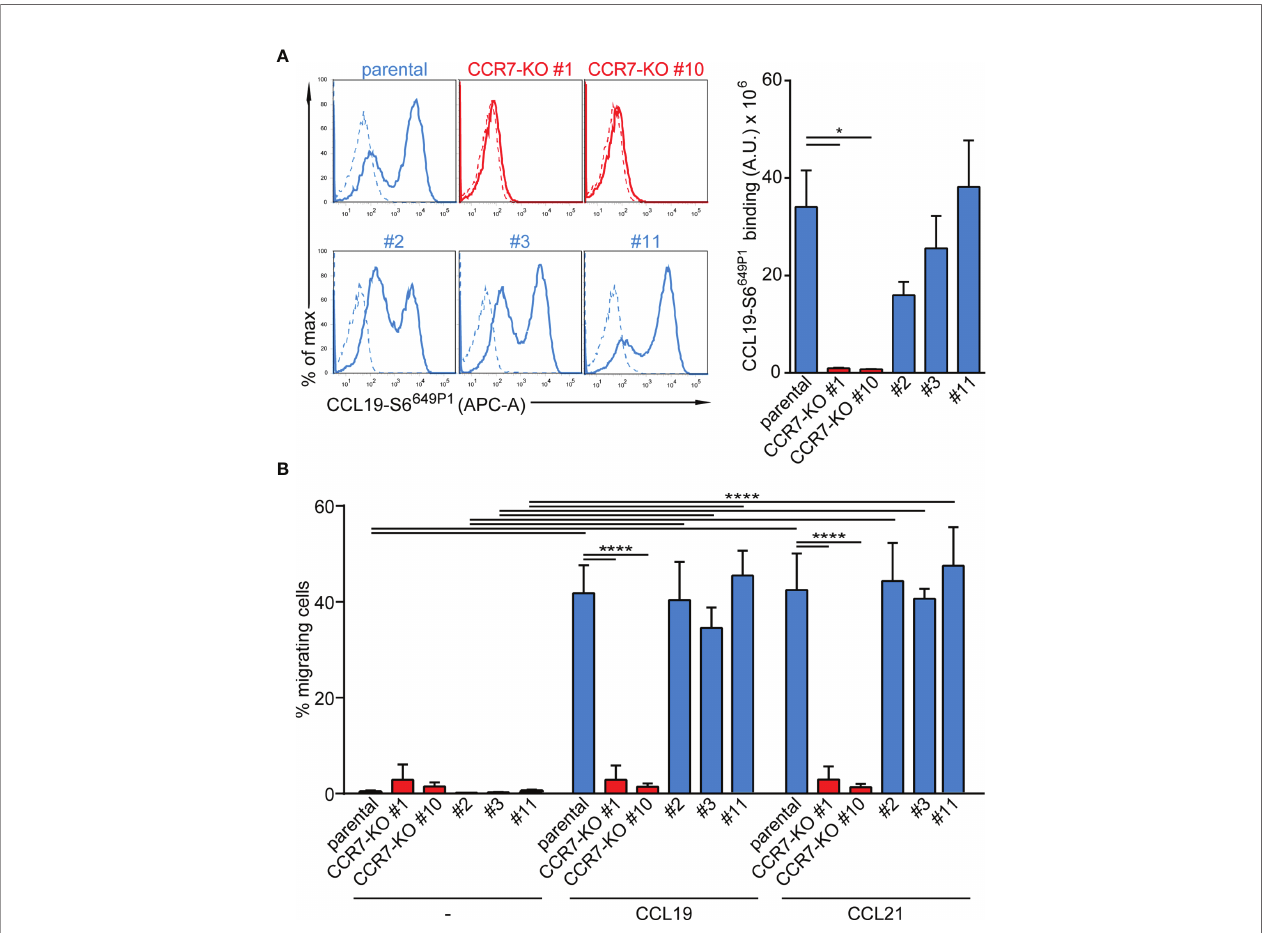
FIGURE 6 | Functional characterization of CCR7-KO and parental CAL-1 single cell clones. (A) R848-matured GM/CAL-1 CCR7-KO single cell clones fail to bind fl uorescent CCL19-S6 649P1 , while R848-matured parental GM/CAL-1 cells or individual parental single cell clones bind the fl uorescent chemokine. Cells (1.8x 10 5 ) were incubated for 30min with 20nM of fl uorescent chemokine at 7°C. Chemokine binding was measured by fl ow cytometry. Representative histograms (solid lines: with chemokine, dashed lines: without chemokine) and quanti fi cation of CCL19-S6 649P1 binding to R848-matured GM/CAL-1 cells (parental), GM/CAL-1 CCR7-KO clone #1 and #10, as well as three single clones (#2, #3, #11) established from parental CAL-1 cells. A representative histogram plot and mean values ± SEM of 3 independent experiments are shown. For quanti fi cation, the area under the curve [A.U.] was calculated by multiplying the mean CCL19-S6 649P1 fl uorescence intensity (MFI) values by the event count of live cells. (B) R848-matured GM/CAL-1 single cell clones retain their migratory capacity while CCR7-KO clones do not. R848-matured parental GM/CAL-1 and individual single cell clones were assessed by 2D Transwell migration assays in response to medium ( – ), 30nM CCL19 or CCL21 for 3h. Percentage of migrating cells was determined by fl ow cytometry. Mean values ± SD of 3 independent experiments are